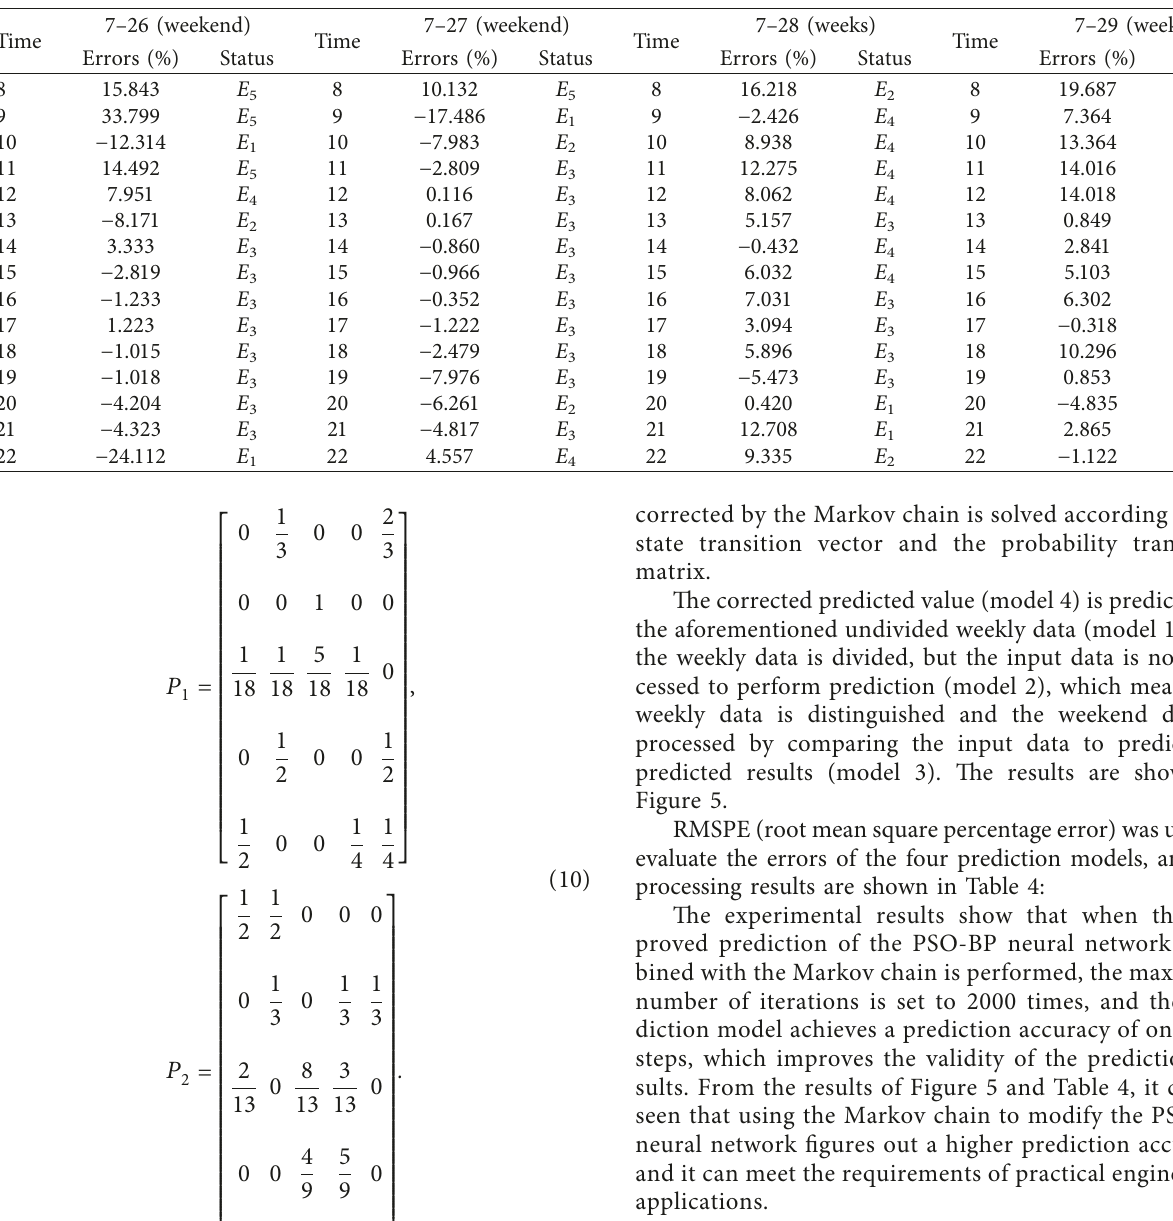
Table 3: PSO-BP neural network prediction error classification